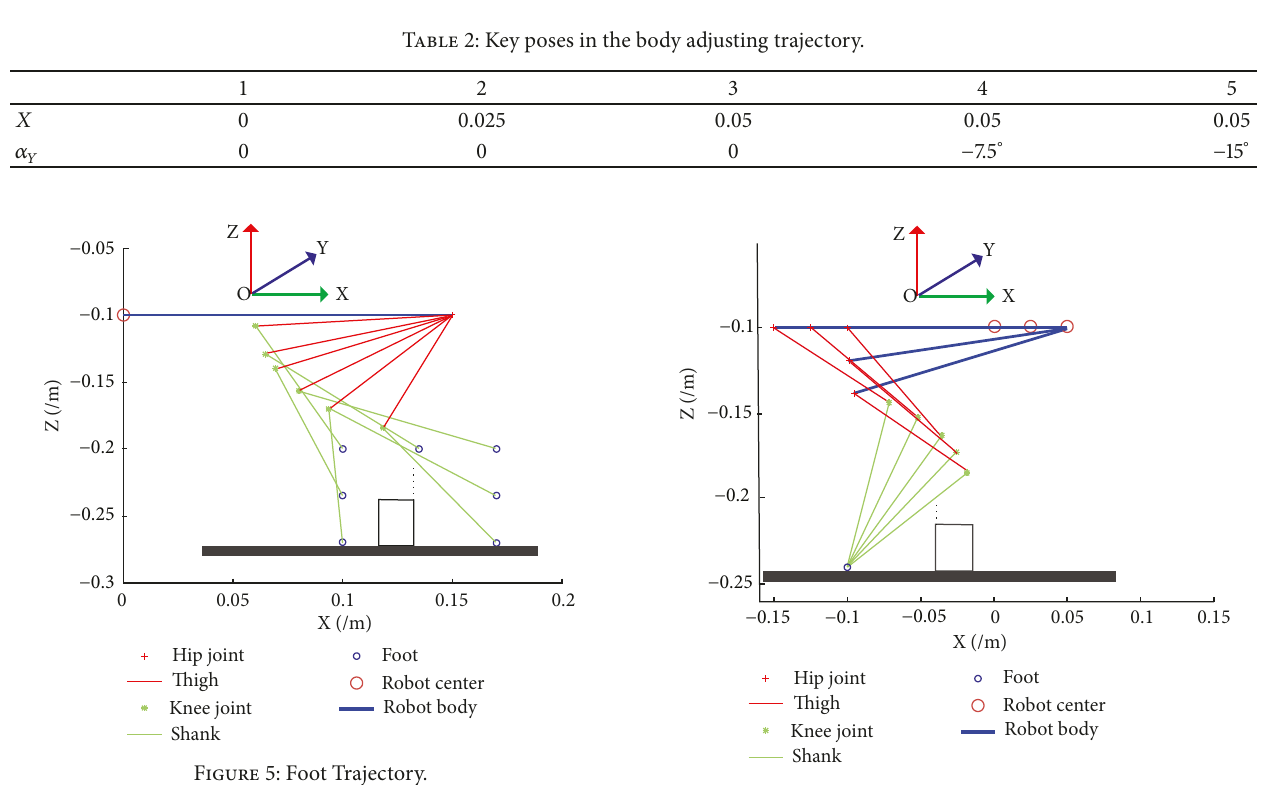
Figure 6: Moving trajectory of the robot